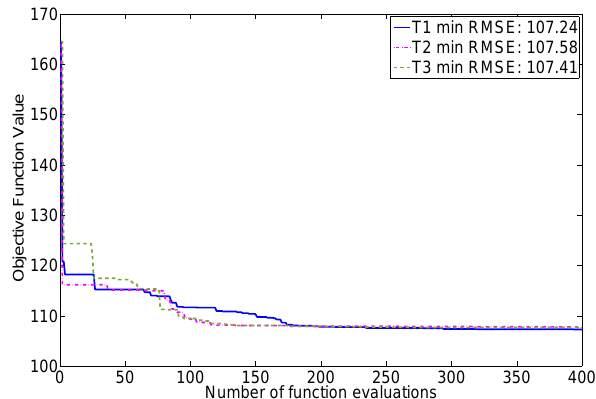
Figure 7. Progress plot that shows the development of the best ob- jective function value found vs. the number of function evaluations for the real data case with d = 11 parameters for optimization tri- als T1, T2, and T3. The legend shows the lowest RMSE value found in each trial. The first function evaluation (left side of the graphs) corresponds to the RMSE when using the default